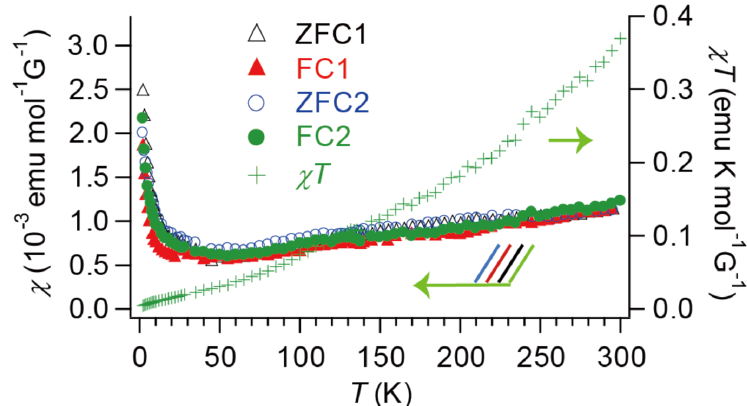
Figure A1. Temperature dependence of electrical resistivity of  -STF 2 I 3 . The samples in Figure A1 a , b are different from those in Figure 3a,b: ( a ) Enlarged view (~80–300 K). Red; heating-process data, blue; cooling-process data. (Inset) A different plot of the same data for comparison with Figure 3b. Since there are deviations in the data during the measurement, T min (  ) is determined based on the first derivative of resistivity by temperature; ( b ) First derivative of resistivity by temperature; enlarged view (~80–300 K).